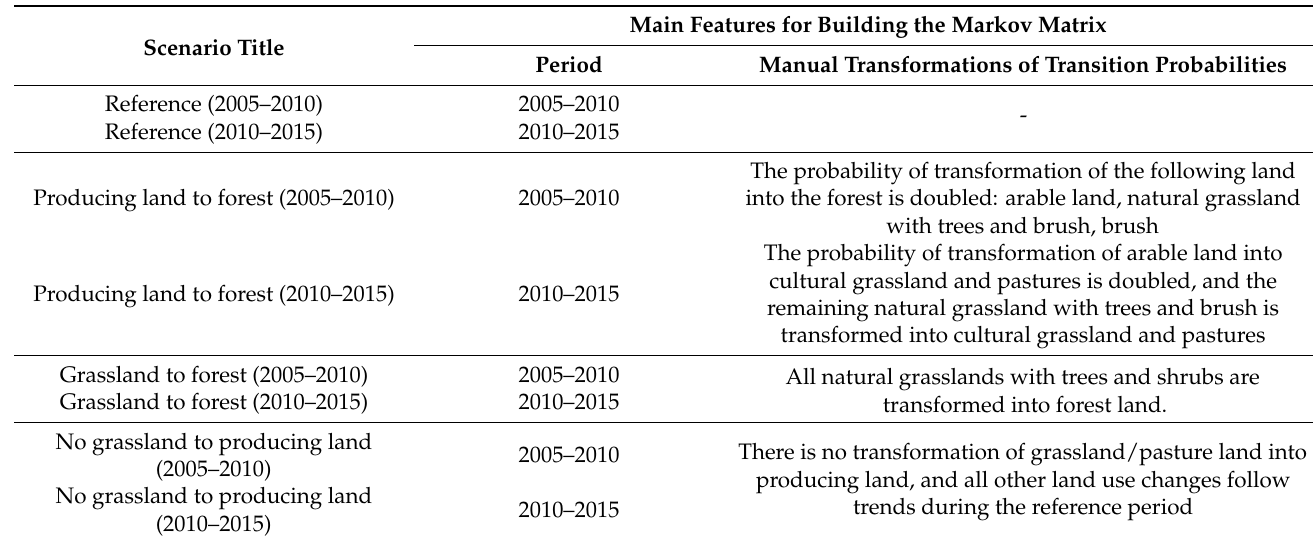
Table 2. Description of future scenarios of land use